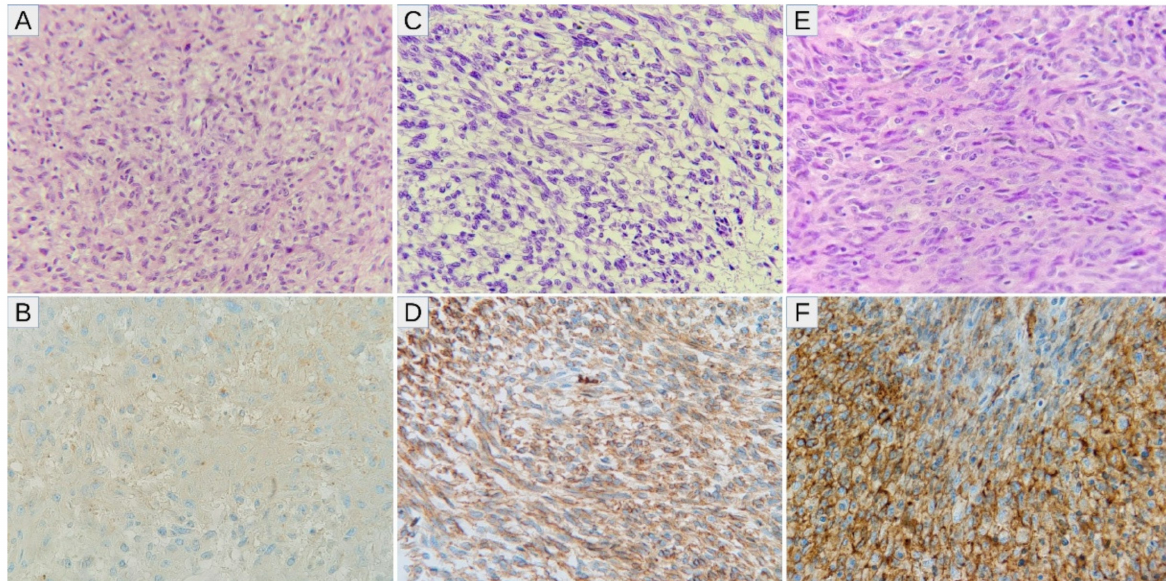
Figure 2. ( A – F ) Representative SLC2A1 staining patterns in MPNSTs with the accompanying hematoxylin/eosin images: ( A , B ) A case with low-intensity (1+) membrane-cytoplasmic expression of SLC2A1 (the expression coefficient—7, low- expression). ( C , D ) Intermediate-intensity (2+) membranous staining intensity; (the expression coefficient—11, high- expression). ( E , F ) Predominantly strong (3+) to intermediate (2+) intensity membranous immunoreaction with SLC2A1 (the expression coefficient—12, high-expression). Abbreviations: SLC2A1—solute carrier family 2 member 1, MPNST— malignant peripheral nerve sheath tumor.